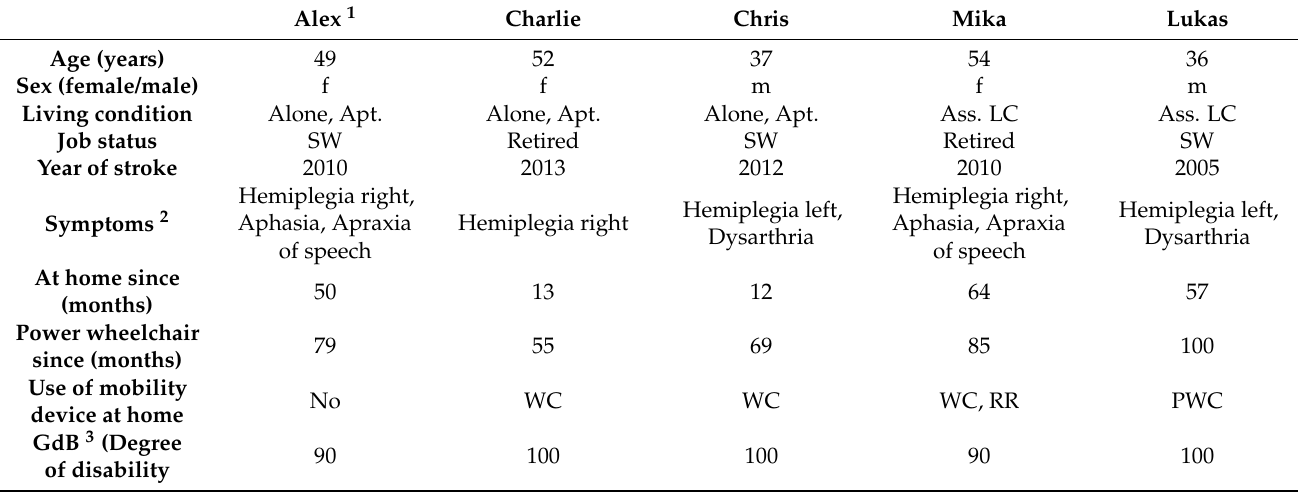
Table 2. Characteristics of the